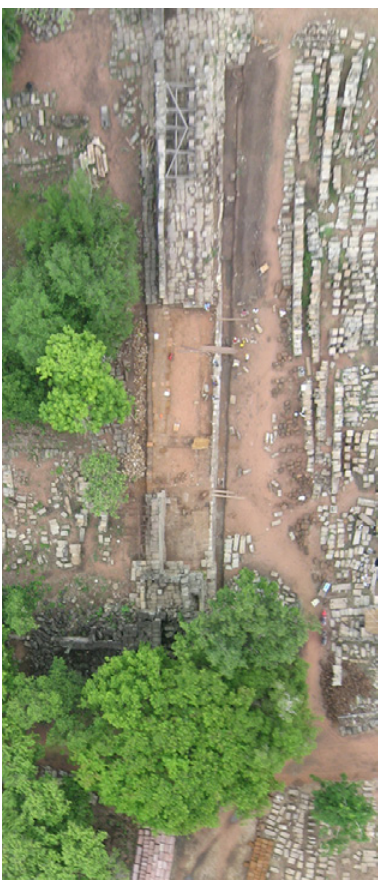
Figure 7: View of the south-east-gallery in Banteay Chhmar, Cambodia.